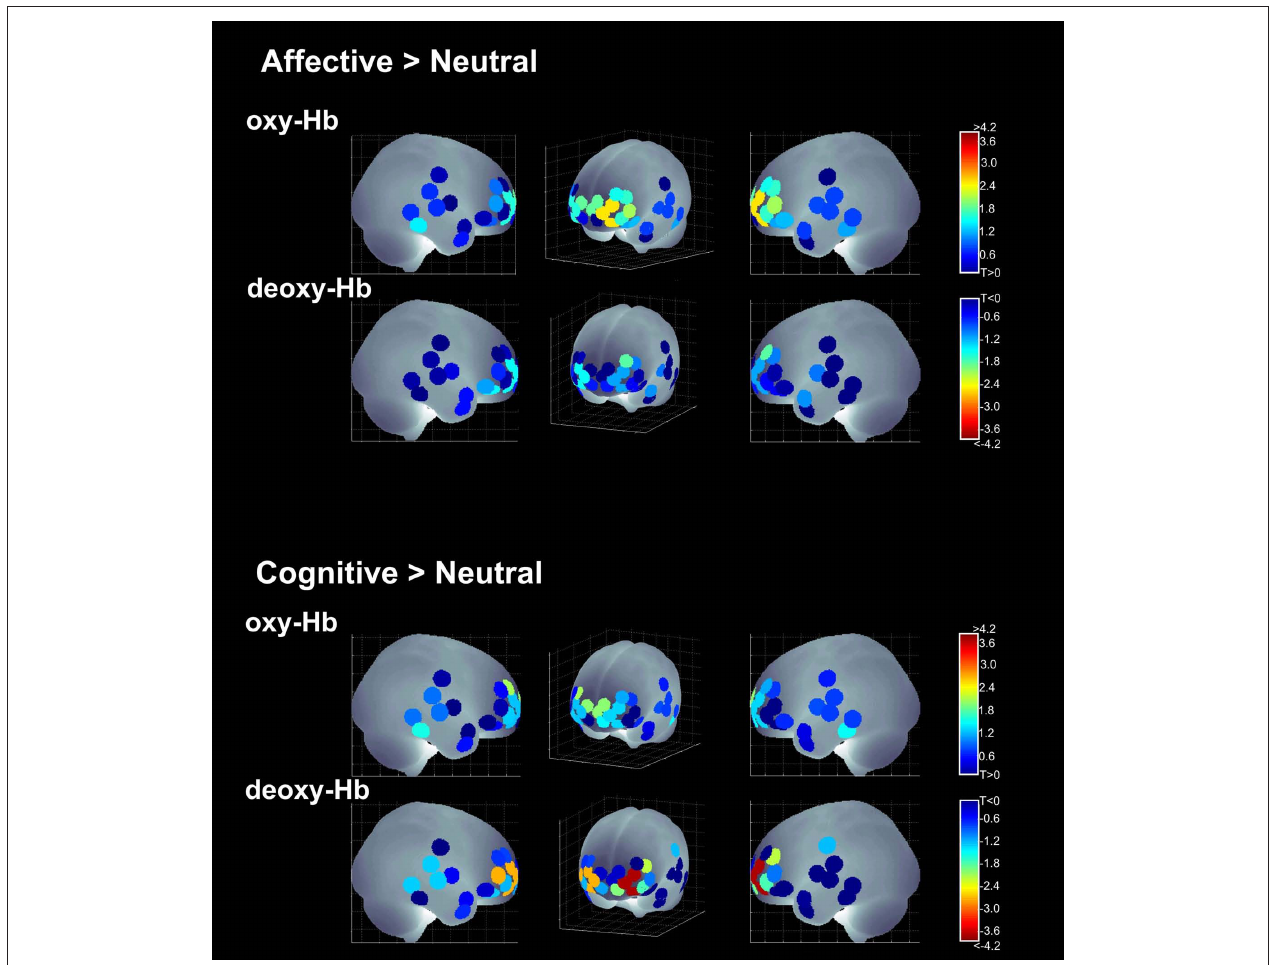
FIguRe 6 | Activations for the auditory condition; [oxy-Hb] and [deoxy-Hb] results across all four main contrasts in the sagittal and a frontal